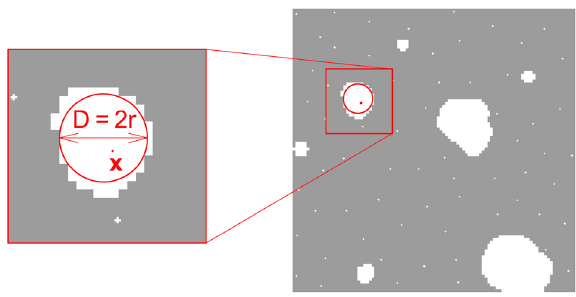
Figure 5. Element thickness at point x as the maximum diameter of the inscribed circle.